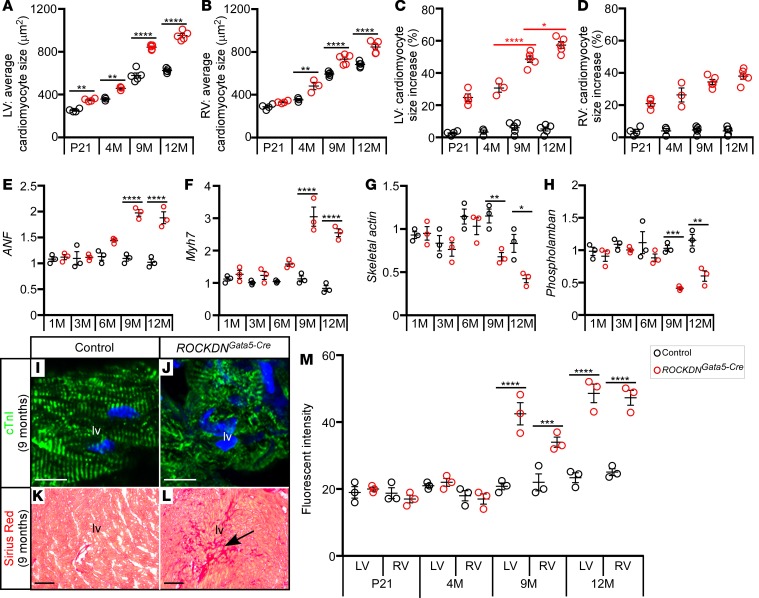
Adult ROCKDNGata5-Cre mutants develop left ventricular hypertrophy, fibrosis, and re-expression of fetal genes from 9 months.(A and B) Four-chamber-view sections of dissected hearts from P21 and 4-, 9-, and 12-month control and ROCKDNGata5-Cre mutants were stained with WGA to allow the average area of the cardiomyocytes to be calculated from left (A) and right (B) ventricles. In the left ventricle, cardiomyocytes were significantly larger in ROCKDNGata5-Cre mutants compared with controls at all ages, and in the right ventricle cardiomyocytes were significantly larger from 4 months (black lines). The average percent increase in cardiomyocyte size in ROCKDNGata5-Cre mutants compared with controls was calculated. In the ROCKDNGata5-Cre mutants, there was a significant change from 4 to 9 months (from 27% to 43%) and from 9 to 12 months (43% to 52%) in the left ventricle (C), with no corresponding significant increase in the right ventricle (D). Hence, there was a specific increase in left ventricular hypertrophy in the ROCKDNGata5-Cre mutants. n=4 P21, n = 3 4 months, n = 5 9 and 12 months, for each genotype. (E–H) qRT-PCR was used to detect any significant changes in gene expression using cDNA isolated from dissected hearts. In ROCKDNGata5-Cre mutants, compared with control hearts, there was a significant increase in the relative expression of fetal genes ANF and Myh7 from 9 months; and a significant decrease in expression of skeletal actin and phospholamban, which are dysregulated during hypertrophy. (I and J) Immunofluorescence staining with cTnI (green) showed disruption in sarcomere striations at 9 months throughout the heart in ROCKDNGata5-Cre mutants (J) compared with controls (I). (K and L) Patches of fibrosis were seen throughout the heart from 9 months, and there was a significant increase in the levels of fibrosis, calculated from fluorescence intensity measurements, in both ventricles at 9 and 12 months (M). n = 3 for each genotype at each time point for experiments in E–M. Data are presented as mean ± SEM. *P < 0.05, **P < 0.01, ***P < 0.001, ****P < 0.0001 by 1-way ANOVA with Bonferroni’s correction for multiple comparisons. lv/LV, left ventricle; RV, right ventricle; M, month. Scale bars: 50 μm (I and J) and 100 μm (K and L).